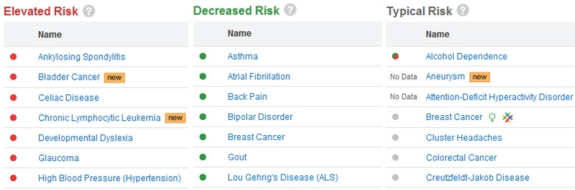
Excerpts from 23andMe’s condition risk profile for a sample patient.